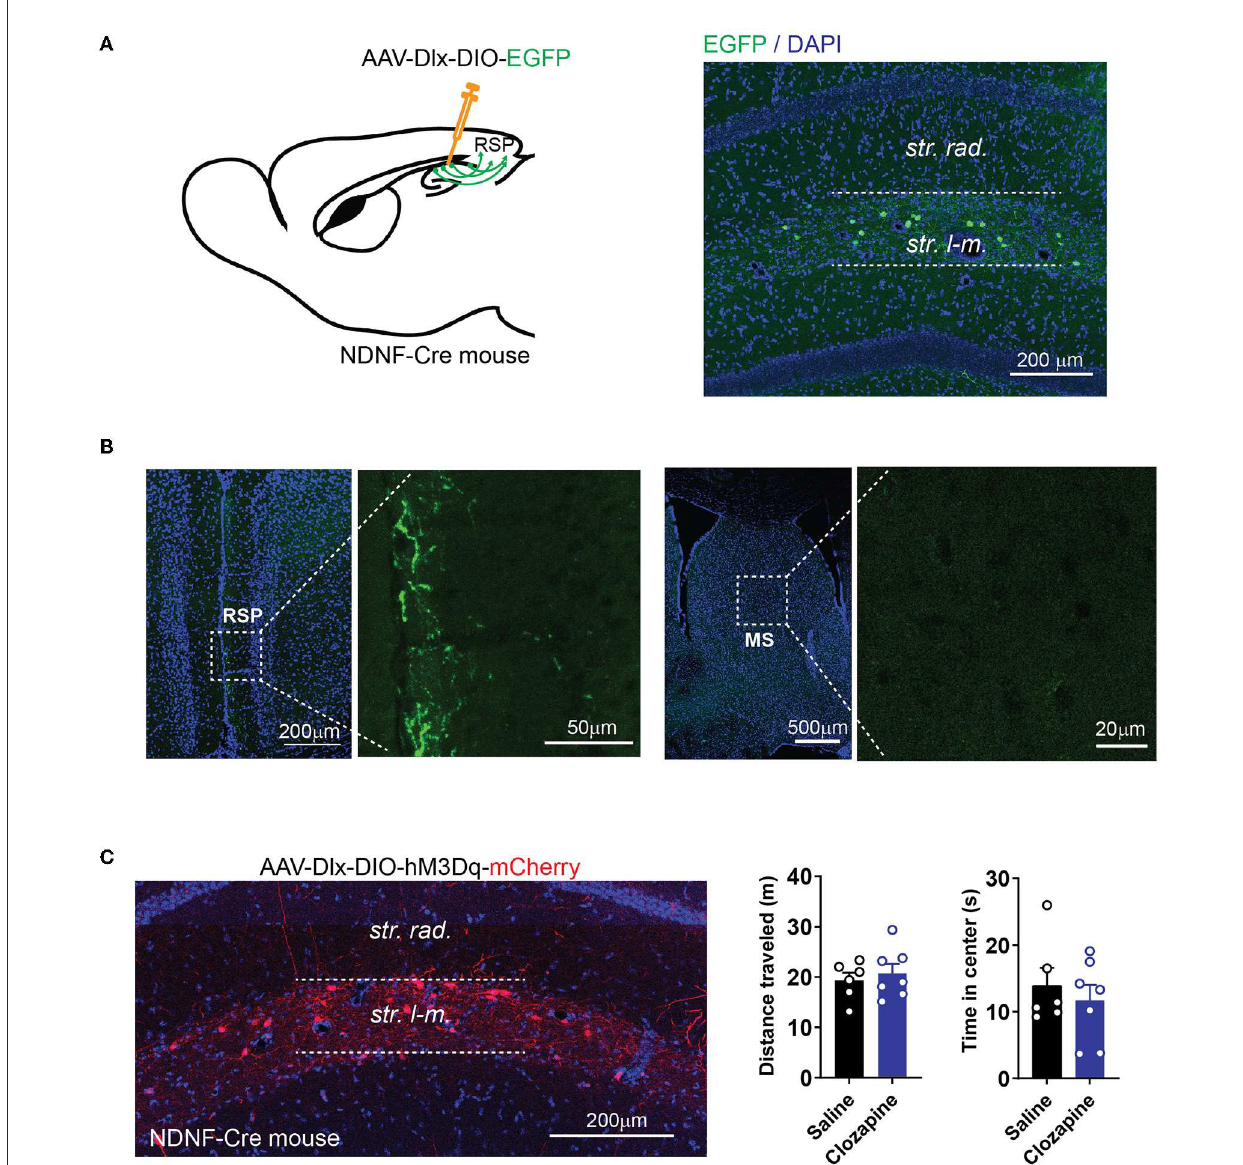
FIGURE6 Activation of cortex-projecting hippocampal interneurons does not change locomotor activity. (A) Expression of EGFP in NDNF-positive interneurons in NDNF-Cre mice by injecting AAV-Dlx-DIO-EGFP into the hippocampus. (B) NDNF-positive interneurons in the hippocampus project to the RSP but not MS. (C) Expression of hM3Dq in NDNF-positive interneurons in the hippocampus (left). Pharmacogenetic activation of NDNF-positive interneurons with clozapine did not alter the distance traveled or time spent in the center of the open field (distance